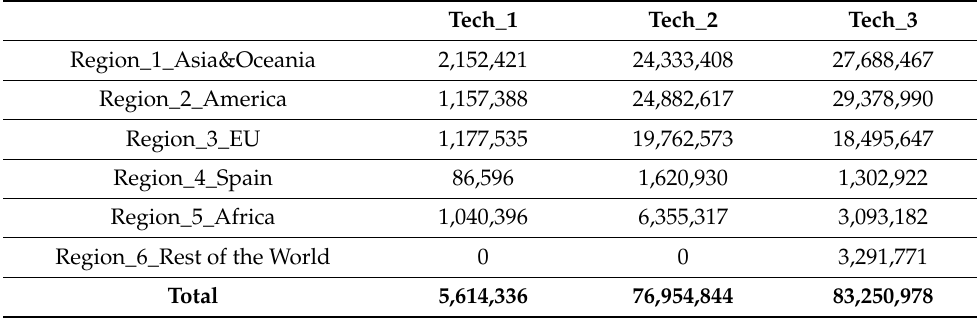
Table 6. Baseline. Solution of x (output) by region and technology (million